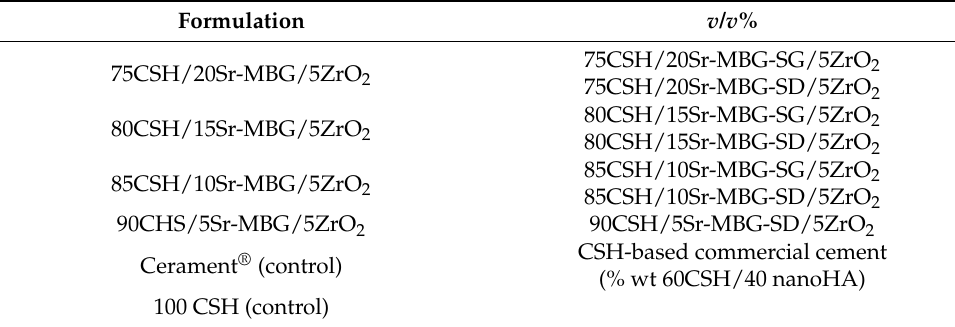
Table 1. Developed formulations of the injectable composite